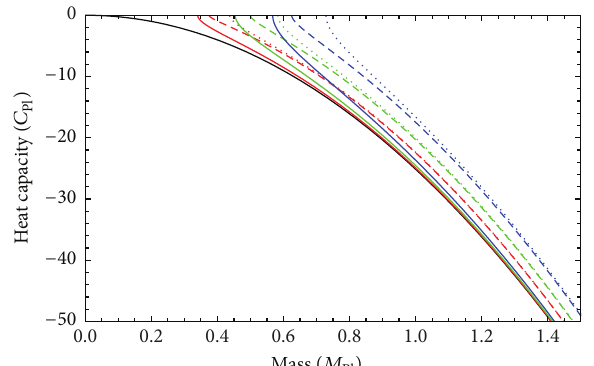
Figure 5: The heat capacity versus the black hole mass for the case 𝑛 = 2 . From left to right: the Hawking result (black solid curve), GUP 2 result (solid curve), GUP 0 result (dashed curve), and GUP 1 result (dotted curve) for 𝛼 = 0.75 (red), 𝛼 = 1 (green), and 𝛼 = 1.25 (blue), respectively.